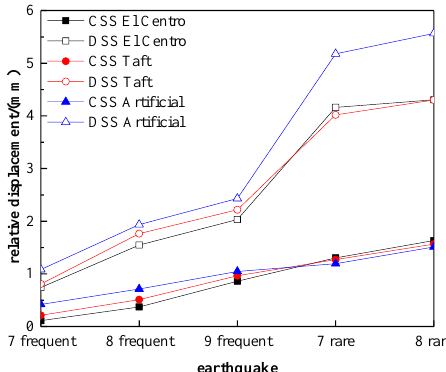
Figure 11. Maximum displacement of a suspended floor relative to the primary structure.